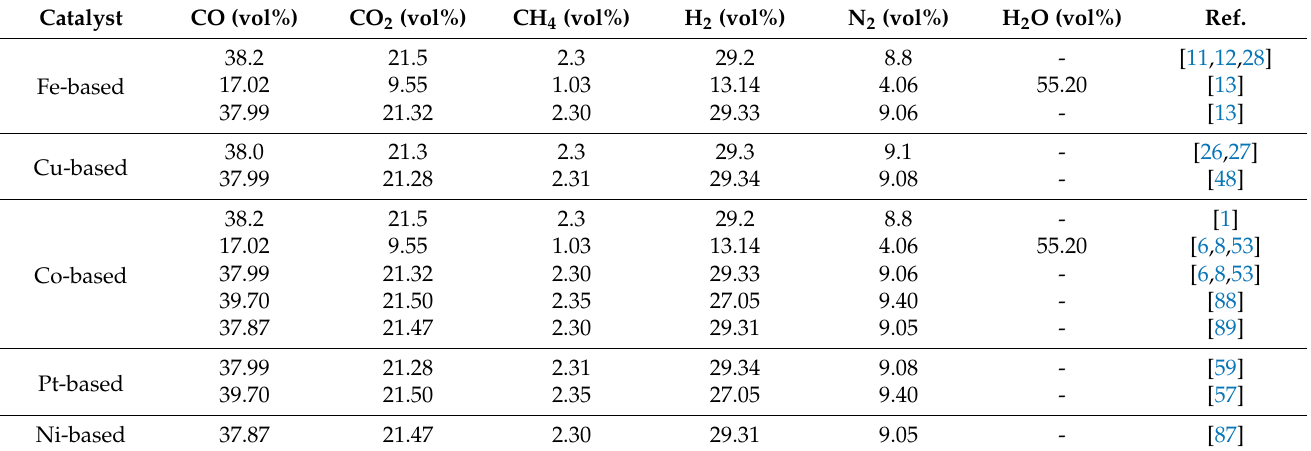
Table 1. Composition of gaseous mixture used in HT-WGS